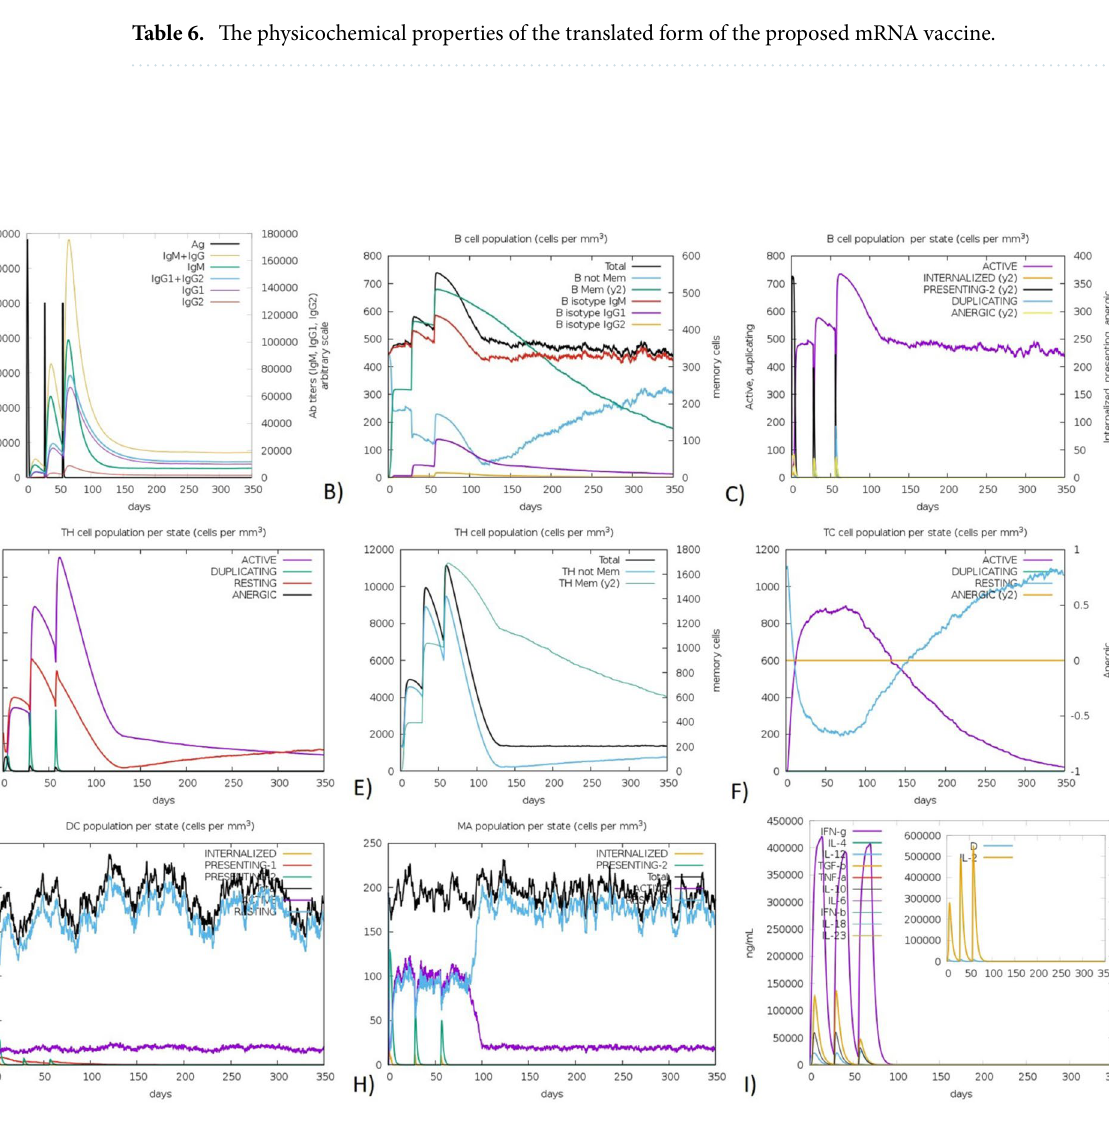
Figure 3. In Silico Immune Simulation against the mRNA vaccine retrieved from the C-ImmSim server. (https:// kraken. iac. rm. cnr. it/C- IMMSIM/). ( A ) The immunoglobulin production after antigen injection. ( B ) The B cell population after three injections. ( C ) The B Cell Population per state ( D ) The Helper T Cell Population ( E ) The Helper T Cell Population per state ( F ) The Cytotoxic T Cell Population per state ( G ) Macrophage Population per state ( H ) Dendritic Cell Population per state ( I ) Cytokines and Interleukins Production with Simpson Index of the immune